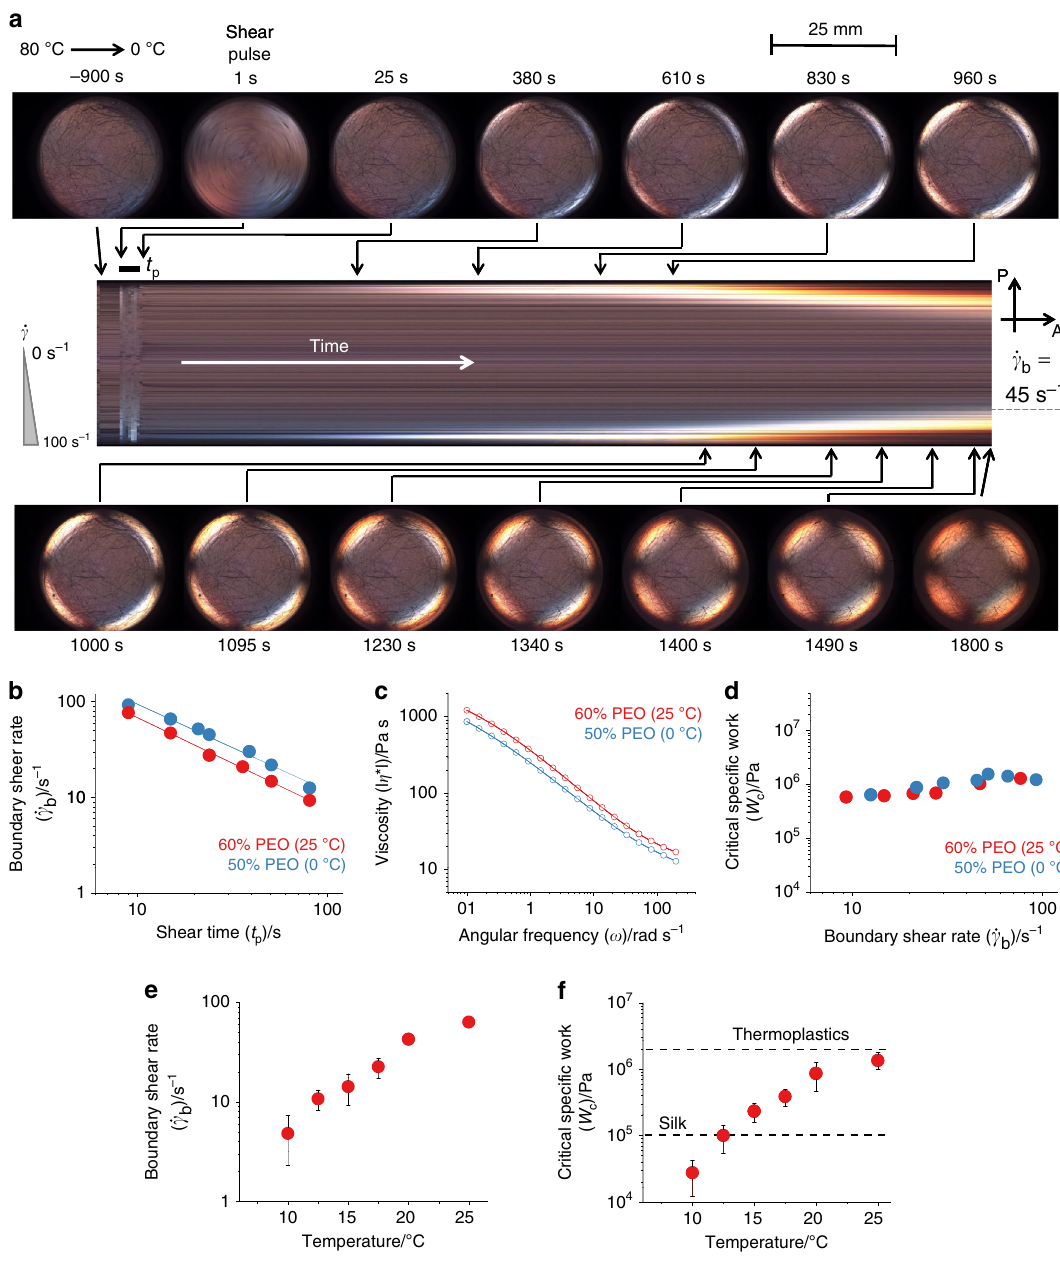
Fig. 3 Flow conditions for nucleation of PEO in water. Measurement of conditions required for fl ow-induced nucleation of PEO in water. a Representative polarised light images (circular images) of a sheared 50% w/w PEO aqueous solution recorded during a SIPLI experiment ( R = 12.5 mm and SIPLI image diameter = 25 mm, d = 0.5 mm, ω = 4 rad/s, and t p = 23 s), with a time-lapse (rectangular image) composed of 45° slices through images over the course of the measurement (see “ Methods ” section), the vectors assigned by P and A show polariser and analyser axis, respectively. b A double-logarithmic plot of boundary shear rate _ γ measured from SIPLI experiments versus time of shearing t p . c Magnitude of complex viscosity of the studied PEO aqueous b solutions measured by a rotational rheometer using a frequency sweep mode. d Critical speci fi c work W c required for fl ow-induced PEO nucleation versus _ γ detected by SIPLI. e , f Effect of temperature on fl ow-induced nucleation of 60% w/w PEO aqueous solution ( _ γ b of t p = 12 s. Error bars, where shown, indicate uncertainty of the as fl ow (Fig. 1b, c), solidify on demand. This phenomenon can be used to solidify PEO aqueous solution through fl ow-induced nucleation analogous to that used by silk worms and spiders. The fl ow can be generated in a controlled fashion by a rotational rheometer following a melt-cool cycle (Fig. 2d).